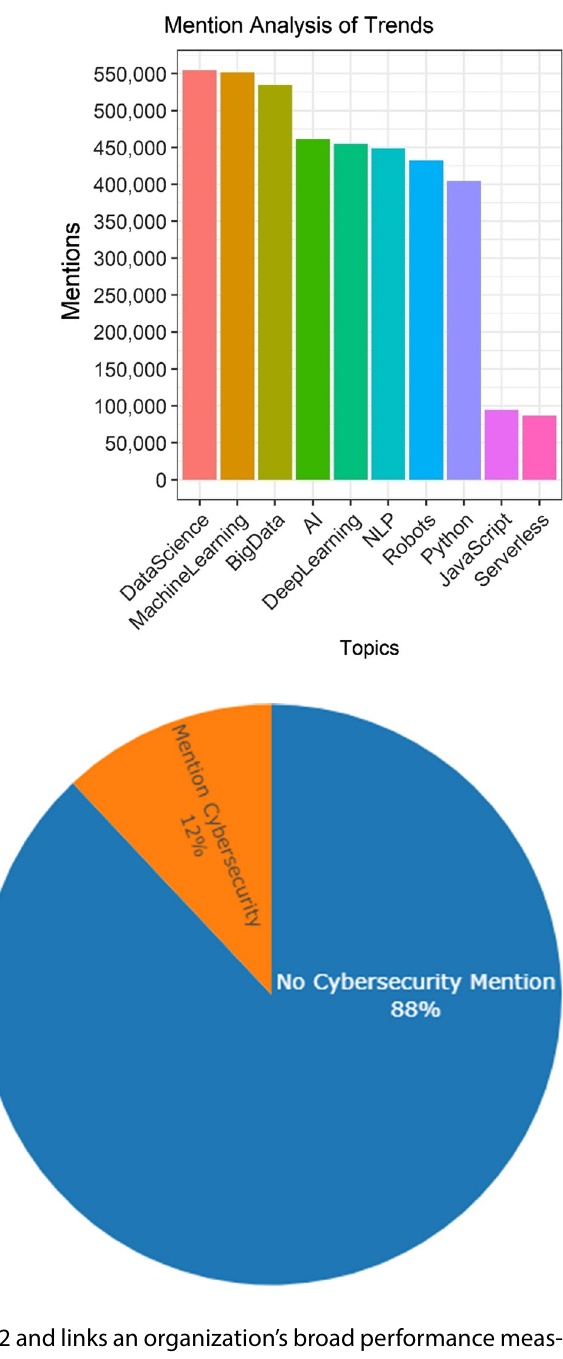
Fig. 6 Only 12% of the total collection of IoT tweets had mention of common cyberse- curity